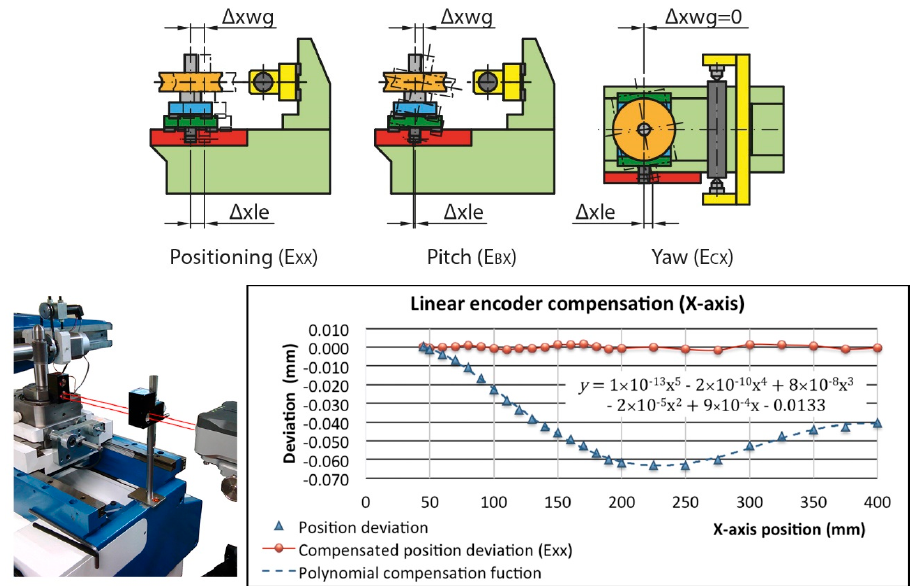
Figure 4. Linear encoder (X-axis) numerical compensation (centre distance position): errors, optics location and results.